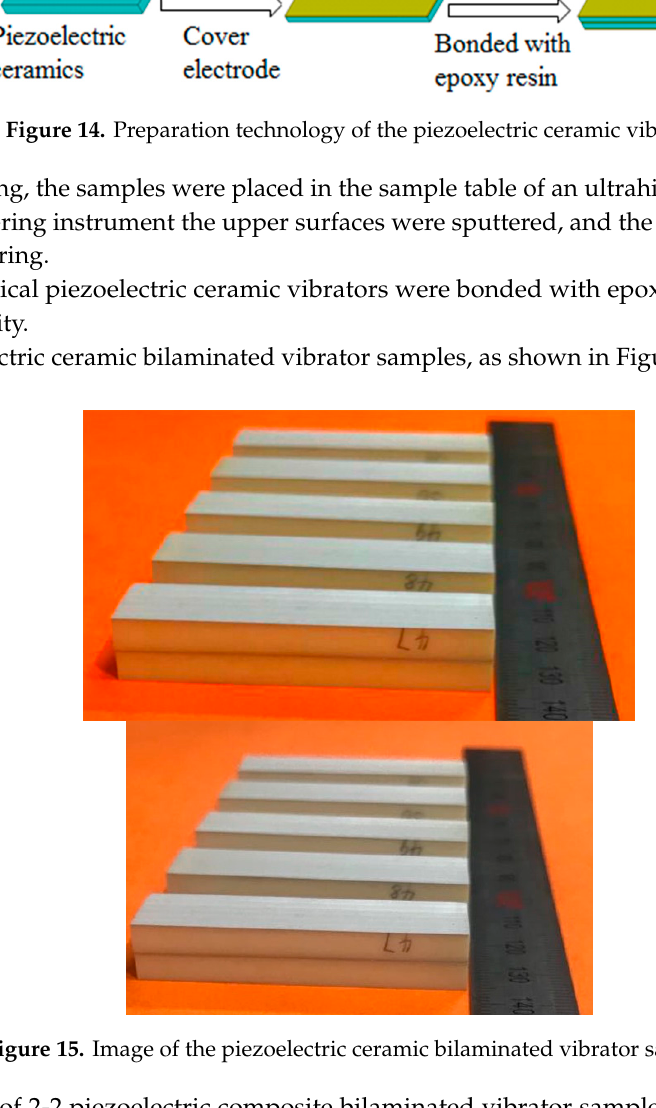
Figure 15. Image of the piezoelectric ceramic bilaminated vibrator samples.